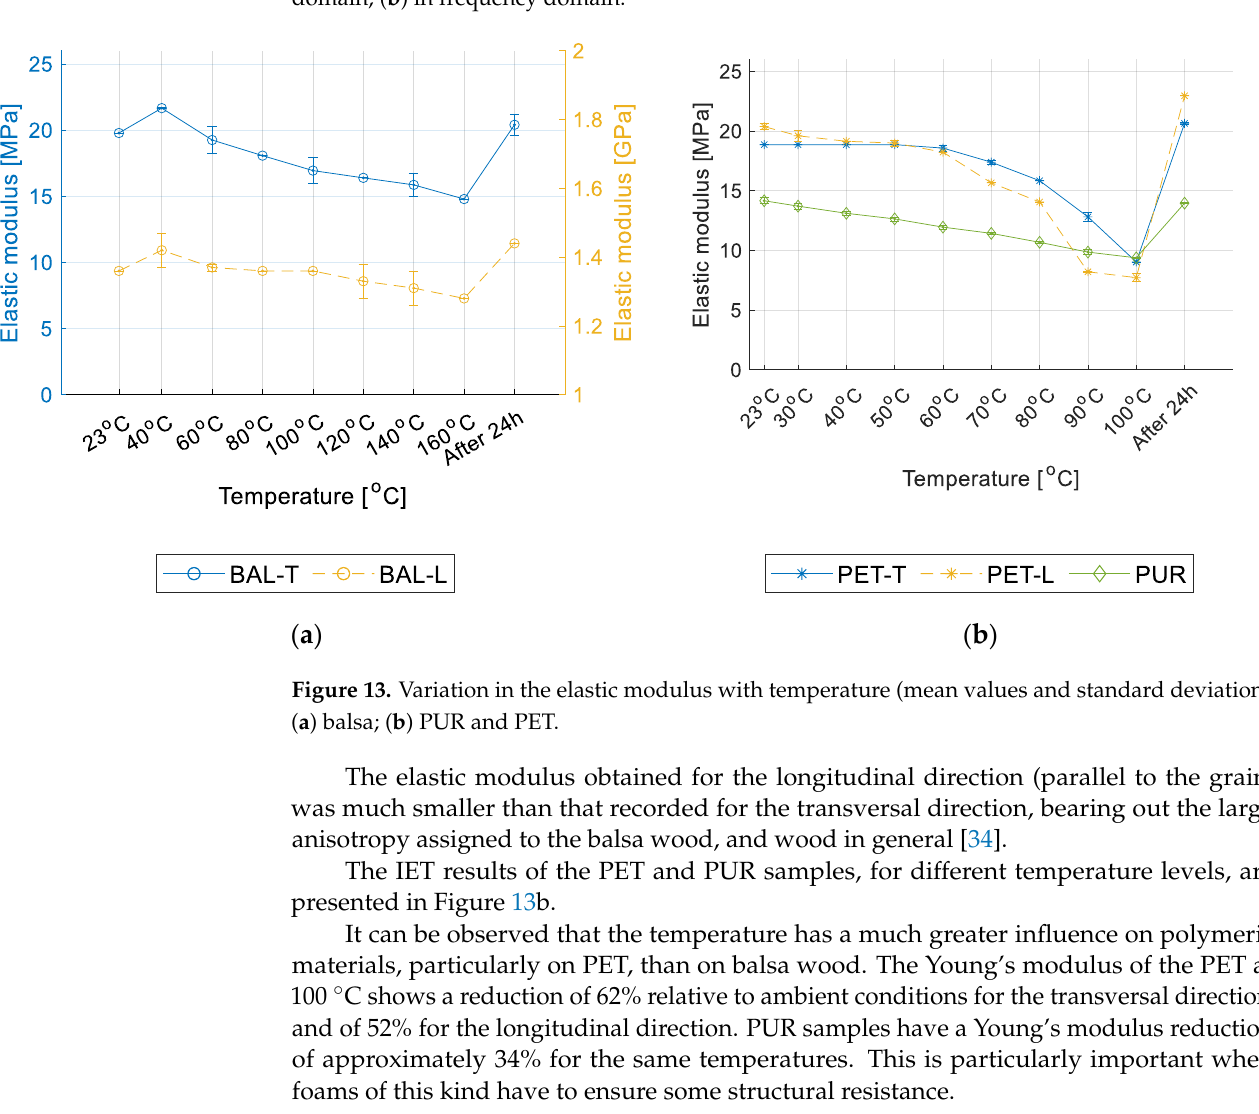
Figure 13. Variation in the elastic modulus with temperature (mean values and standard deviation): ( a ) balsa; ( b ) PUR and PET.